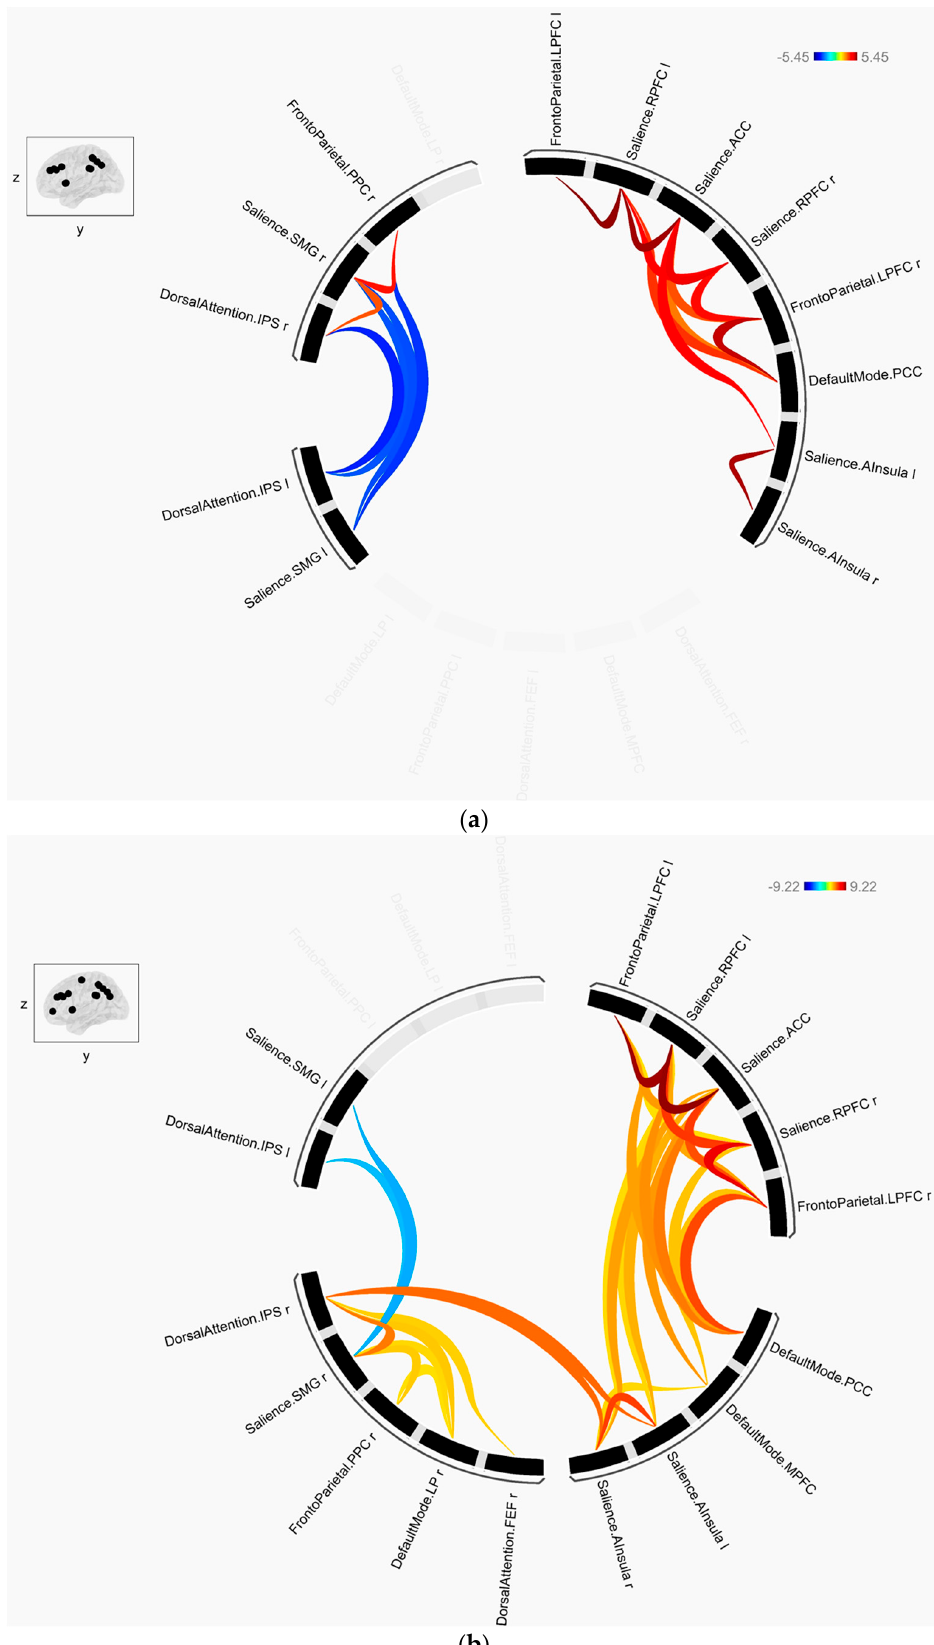
Figure 2. ROI-to-ROI connectivity map of the ( a ) stress and ( b ) recovery phases.